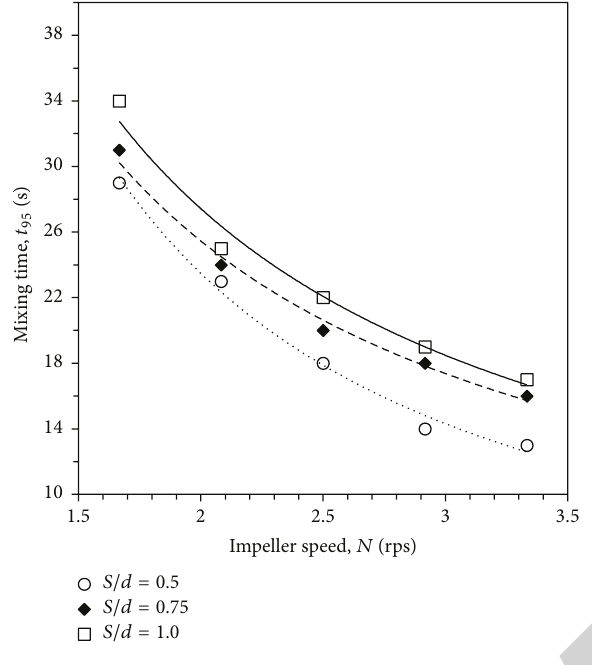
Figure 4: Relation between mixing time and spacing between